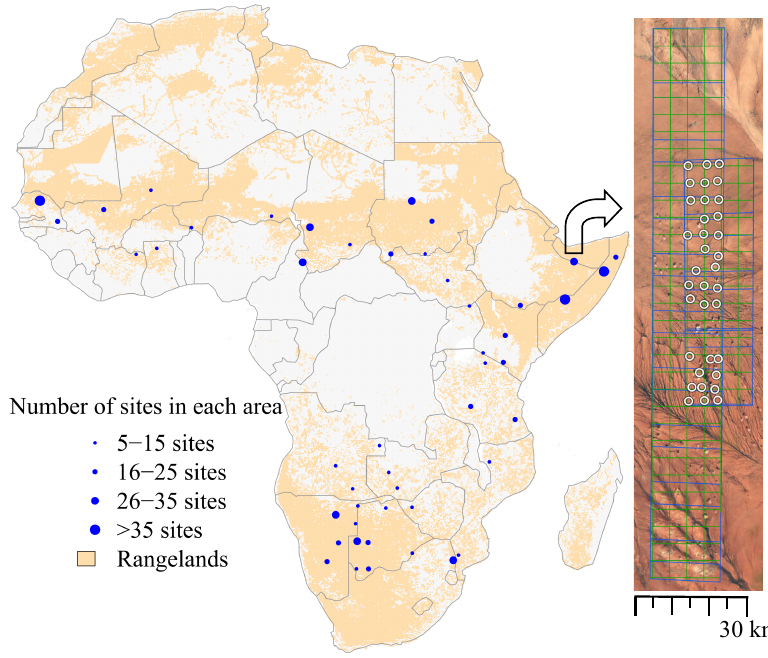
Figure 2. Location of the 48 study areas, containing 876 study sites, spread out over African rangelands. The rangeland areas are from the anthropogenic biomes product (Ellis and Ramankutty, 2008), and symbol size for study areas is proportional to the number of study sites in each. The map to the right shows a study area on the border between Somalia and Ethiopia and exemplifies the sampling strategy for study sites (white rings). The placement of sites was guided by a 0.04 ◦ longitude–latitude grid (green lines) in areas with overlapping older and newer satellite imagery (blue